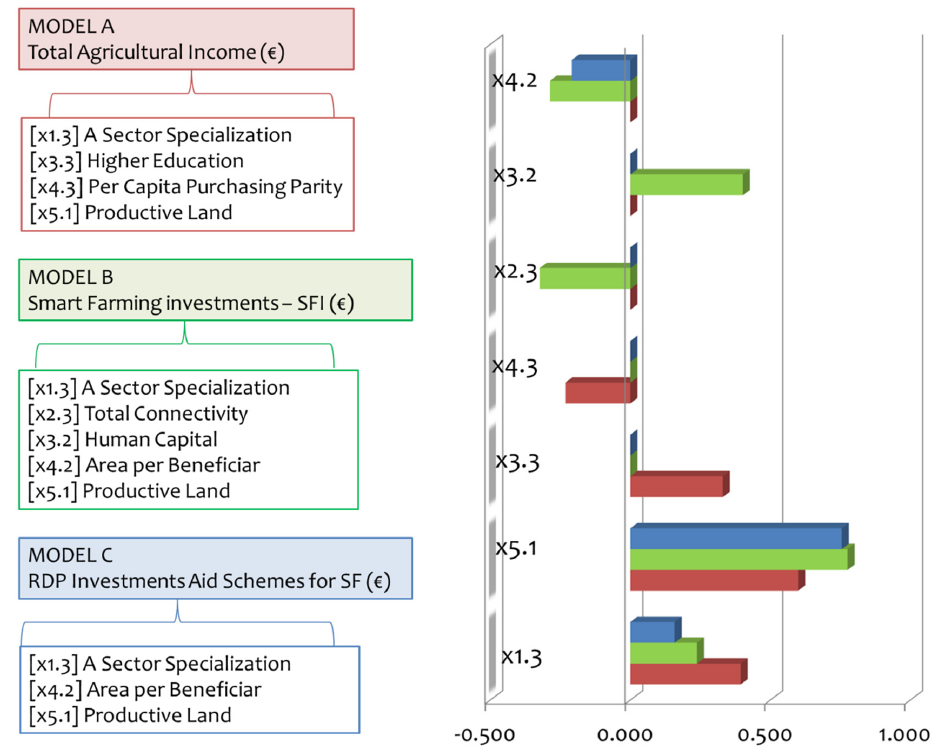
Figure 7. (right) Brace Map of the standardized BEM linear regression coefficients (designed with Lusidchart and (left) the corresponding Clustered Bar Charts (bar colors correspond to the model color) (Lusid Software Inc., Salt Lake City, UT, USA, https://lucid.app/lucidchart/, accessed on 20 February 2023) with only significant predictor variables.